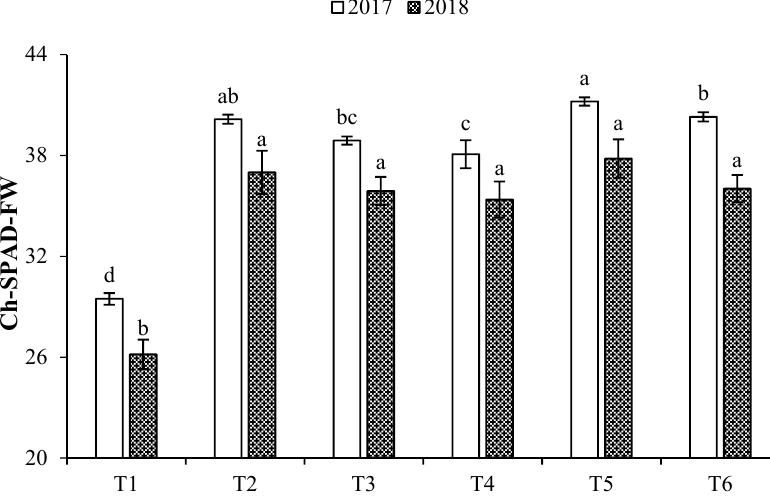
Figure 2. Effect of organic, inorganic, and biofertilizers on leaf chlorophyll content of Jew’s mallow ( Corchorus olitorius L.). Each column represents the mean of three replicates; different letters on similar columns indicate significant differences using Duncan's multiple range test at p ≤ 0.05.